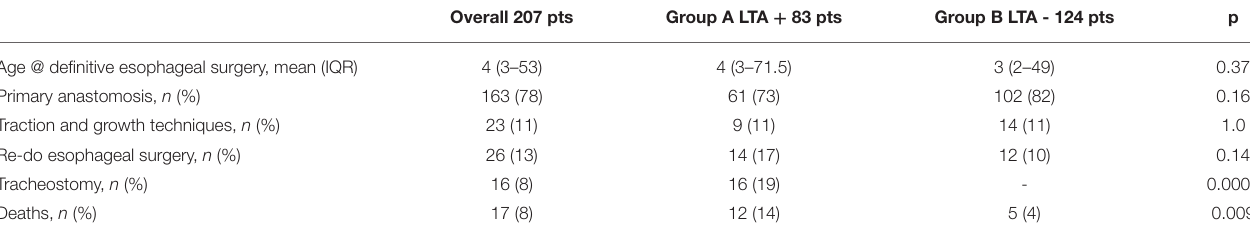
TABLE 3 | Surgical and clinical post-operative